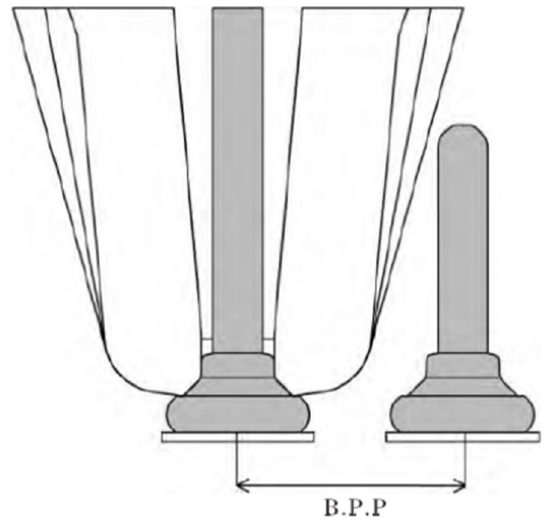
Figure 13. Schematic diagram of wire bonding pitch space of bonding pad.